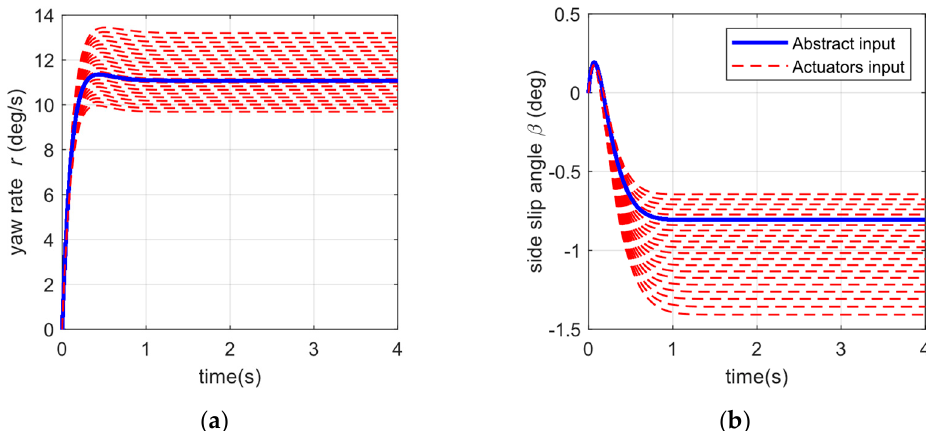
Figure 4. Secondary effects for different distributions for a left turn at 80 km/h and 30 deg steering wheel input. ( a ) Yaw rate responses; ( b ) Side slip angle responses.